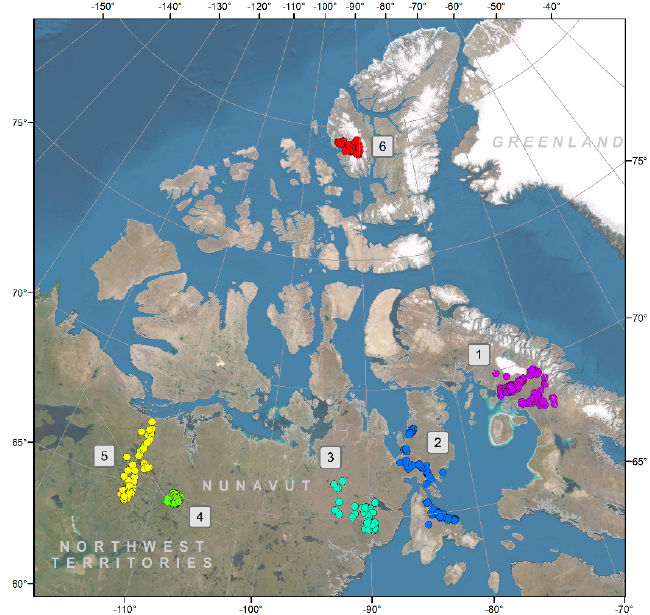
Figure 2. Location of the gossans used in this study with their associate cluster number to highlight their geographical repartition (colors used for better